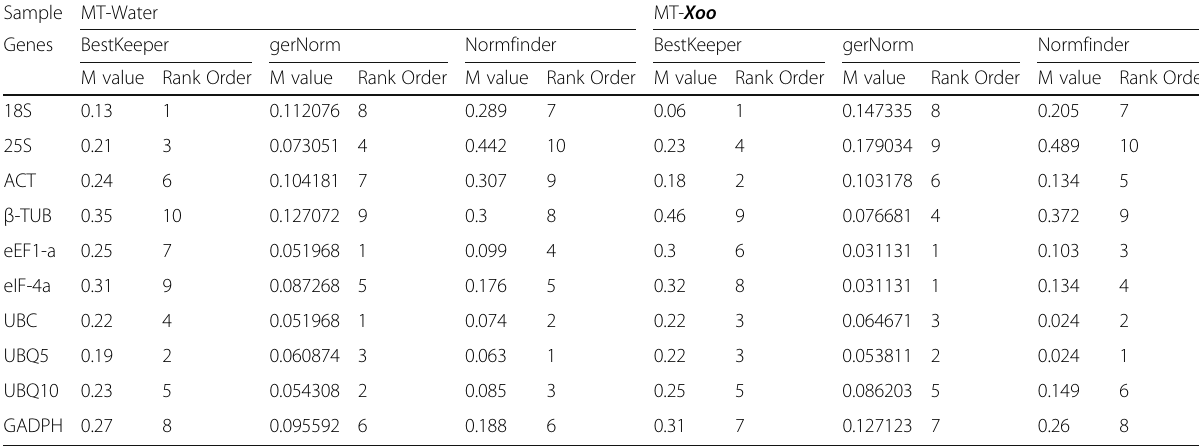
Table 5 Ranking of the candidate reference genes according to their stability value calculated using geNorm, Normfinder and Bestkeeper in PX099-infected rice plant under MT treatments Sample MT-Water MT- Xoo BestKeeper